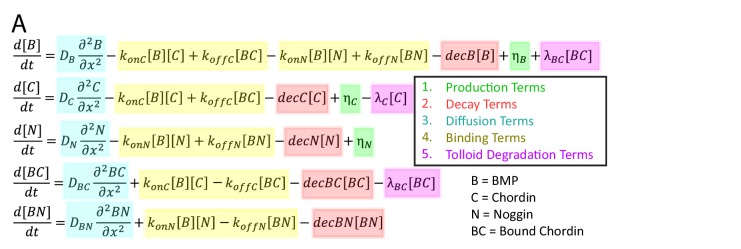
Model-based screen of DV patterning in zebrafish.(A) System of differential equations used for model-based screen.